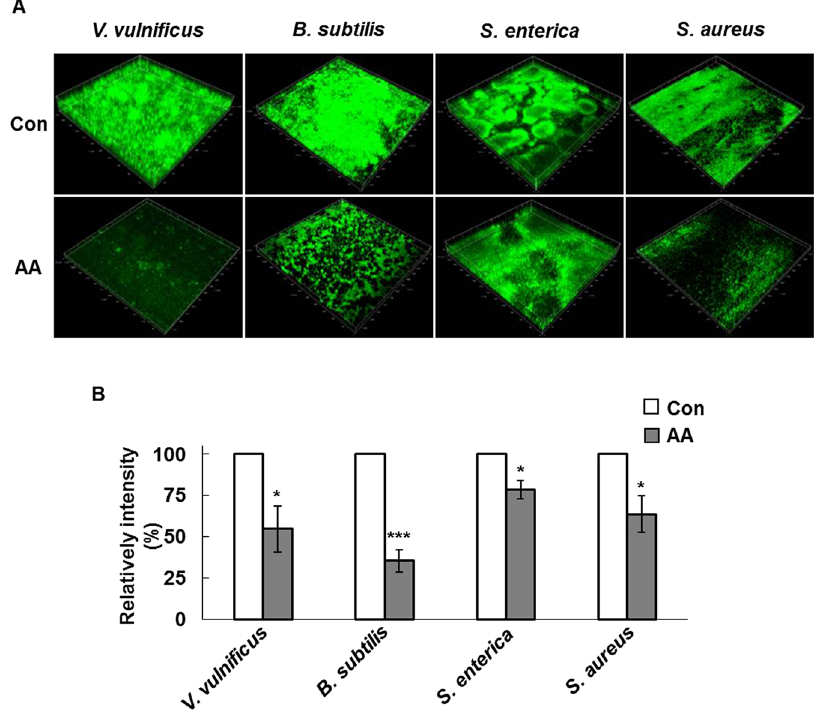
Figure 4. Biofilm inhibition by anthranilate in the presence of shear All strains were grown in flow cell chambers in the presence of 0.1 mM anthranilate for 3–5 days to form biofilms. V. vulnificus , B. subtilis and S. enterica biofilms were stained with 0.1% SYTO 9 for 15 minutes before microscopy, but S. aureus biofilms were detected directly because S. aureus harbors a GFP-expressing plasmid (pAH13). All biofilms were imaged by CLSM ( A ). Fluorescence intensities were quantified and graphed ( B ). Con, control; AA, 0.1 mM anthranilate. * p < 0.05; *** p <